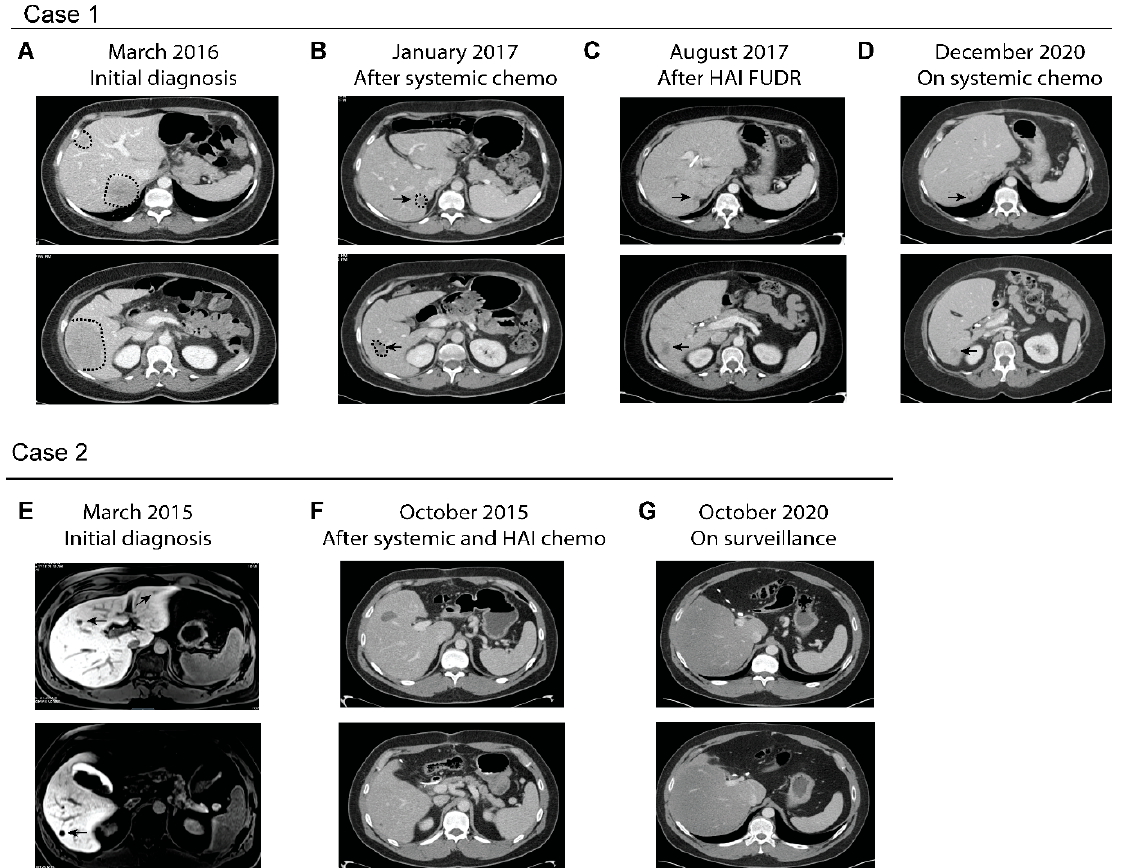
Figure 1. Serial imaging studies of two representative cases treated with systemic and HAIP chemotherapy. ( A – D ) Serial CT images of Case 1. The patient initially presented with metastatic sigmoid colon cancer with bulky disease burden in the liver ( A ). After prolonged treatment with systemic FOLFIRI and panitumumab which led to good treatment response ( B ), she subsequently underwent surgical resection of the primary colon cancer and liver lesions and placement of HAIP. ( C ) CT scans after completion of systemic and HAIP chemotherapy showed post-surgical changes (arrows) which remain unchanged over the following three years ( D ) despite extrahepatic recurrence. ( E – G ) Serial imaging of Case 2. ( E ) Initial MRI showing multiple lesions in Case 2 who had just undergone sigmoid colectomy. The patient was treated with 4 cycles of chemotherapy followed by left liver resection, ablation of liver lesions and placement of HAIP. ( F ) CT after completion of adjuvant systemic and HAIP chemotherapy showed post-surgical changes which remain stable over the following five years ( G